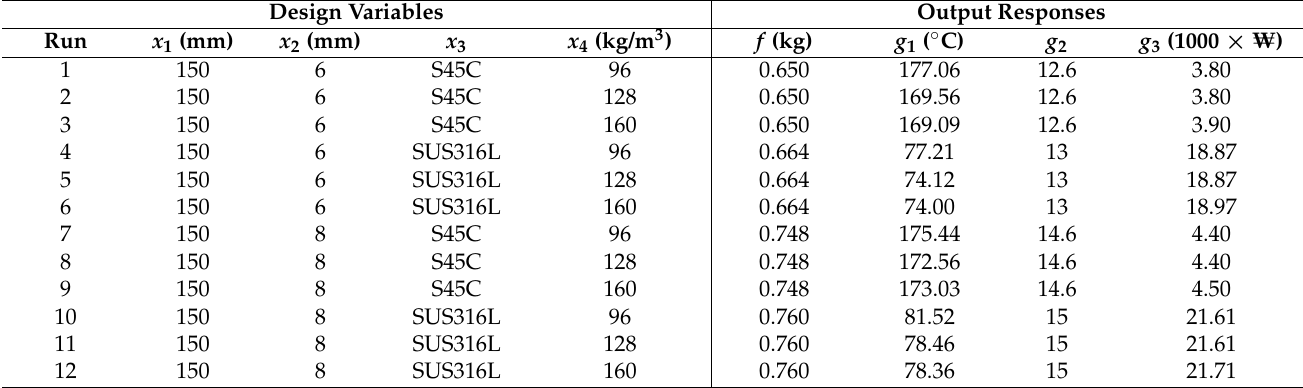
Table A2. Design of experiment (DOE) data for